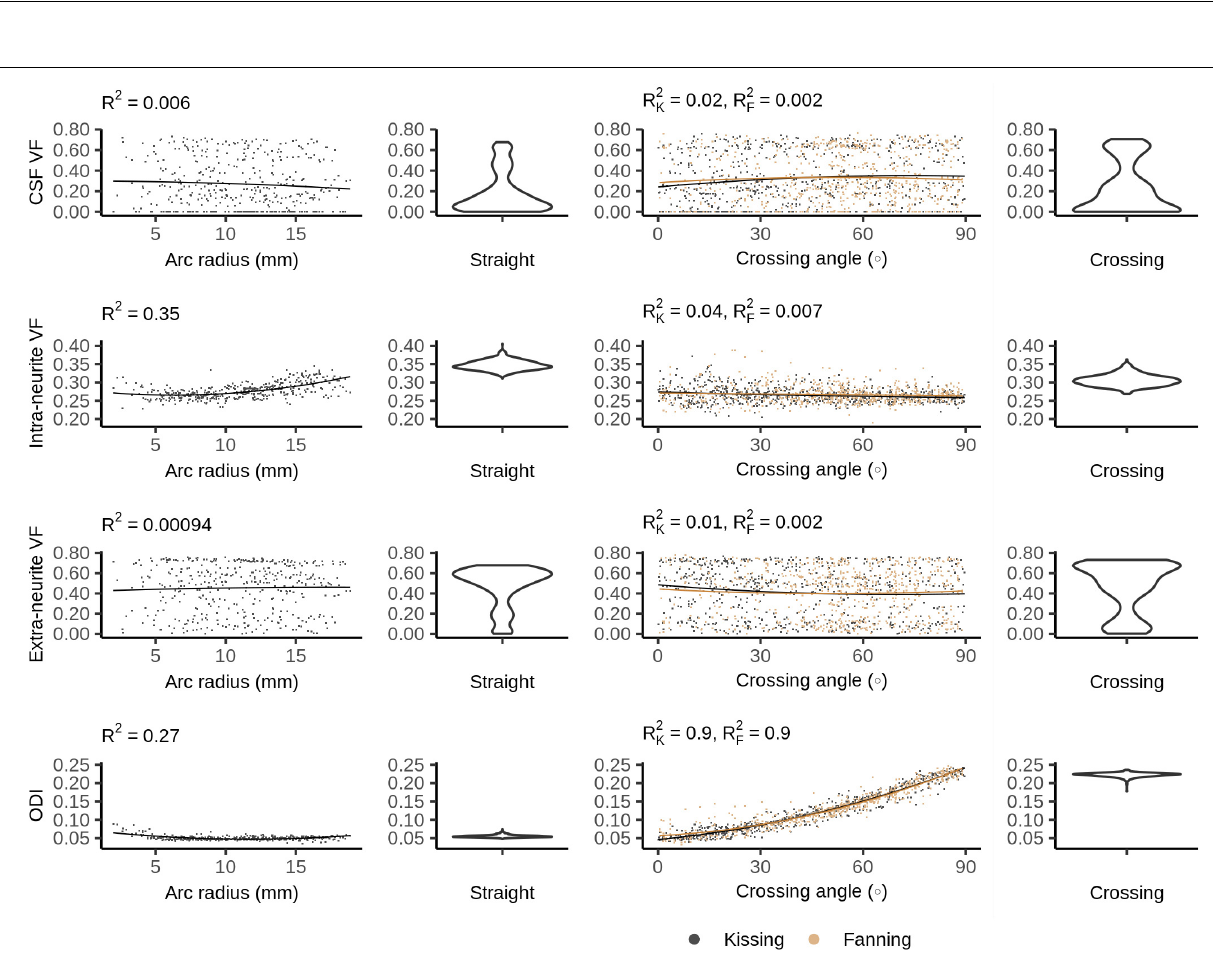
Frontiers in Neuroscience |